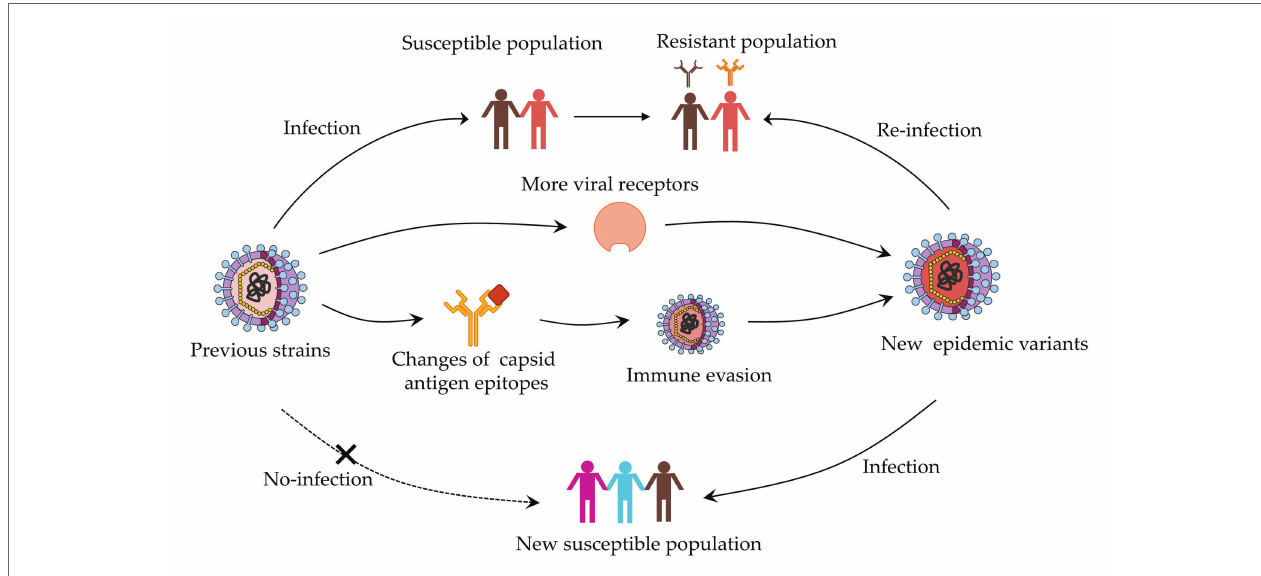
FIGURE 1 | Evolution mechanism of norovirus based on capsid protein